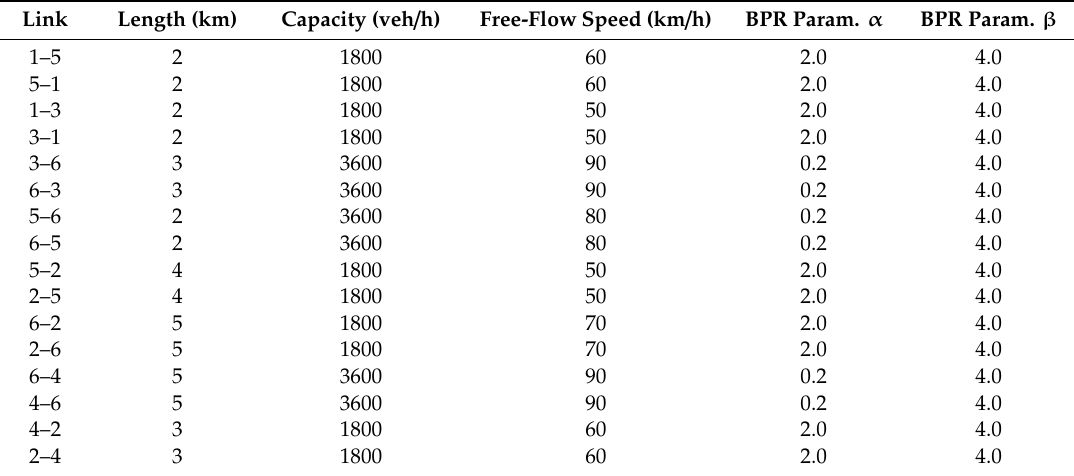
Table 1. Features of the small network.